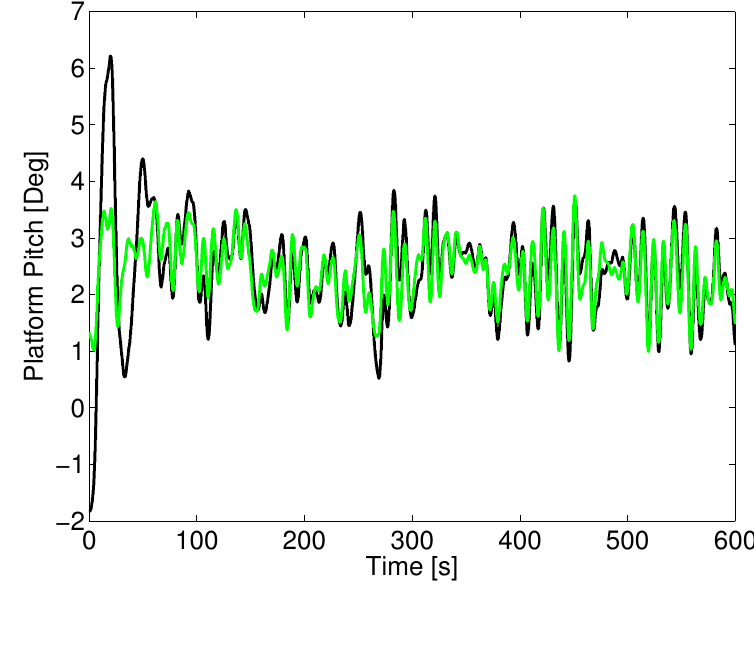
Figure 11. Aligned wind-wave forces with a peak wave period of 10 s: platform pitch. The green is the LQR2 controller, while the black is the